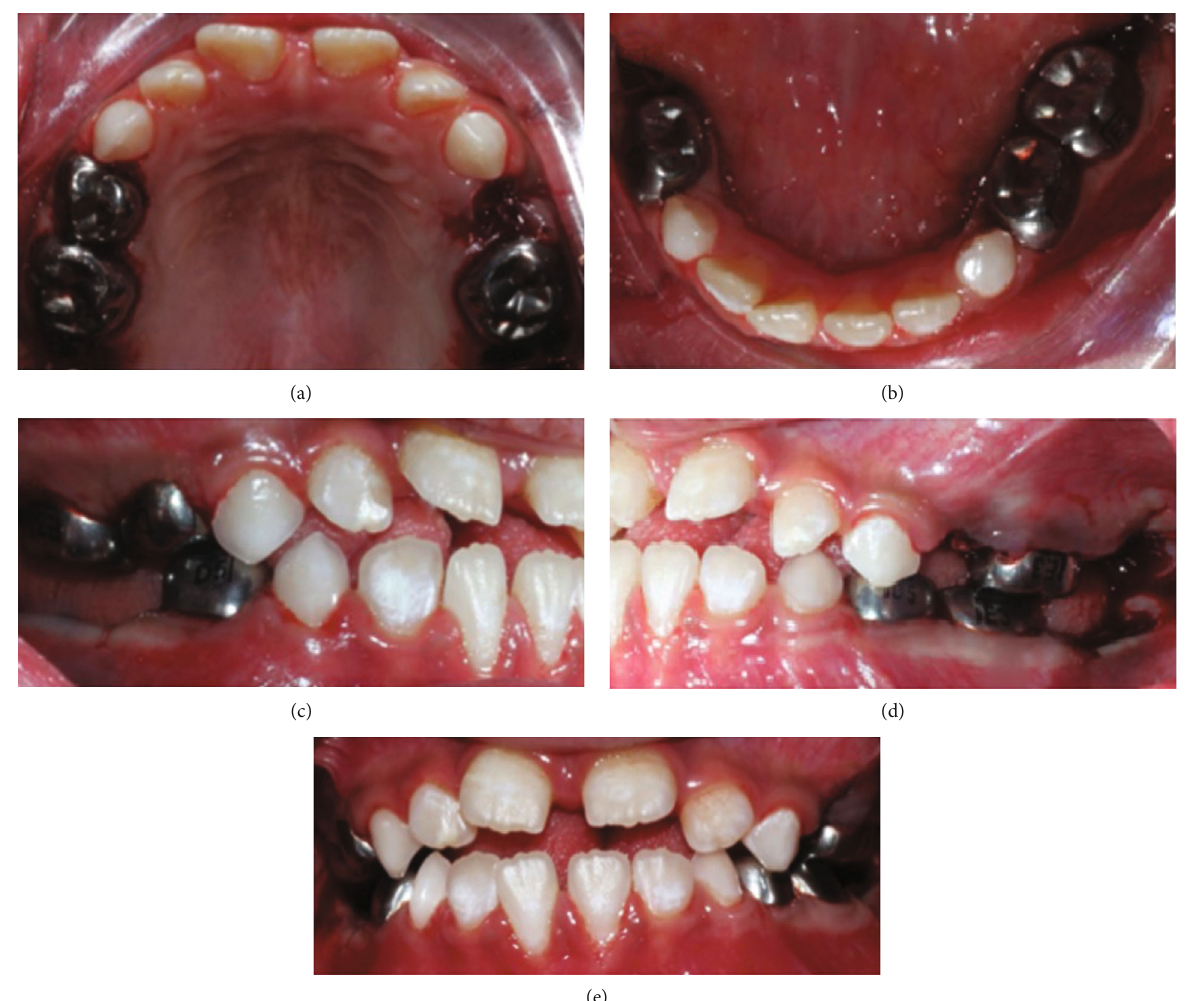
Figure 3: Intraoral postoperative photographs. (a) Maxillary occlusal view. (b) Mandibular occlusal view. (c) Right lateral view. (d) Left lateral view. (e) Frontal